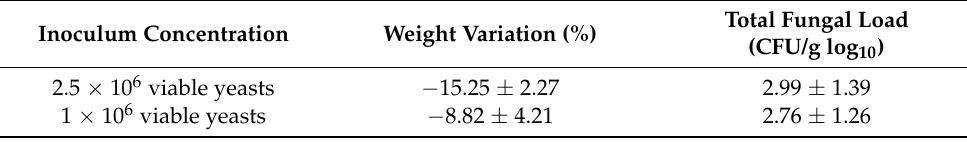
Table 1. Adjustment of inoculum concentration. Female C57BL/6 mice were infected with 2.5 × 10 6 and 1 × 10 6 viable C. tropicalis yeasts and then compared for weight variation and fungal load.